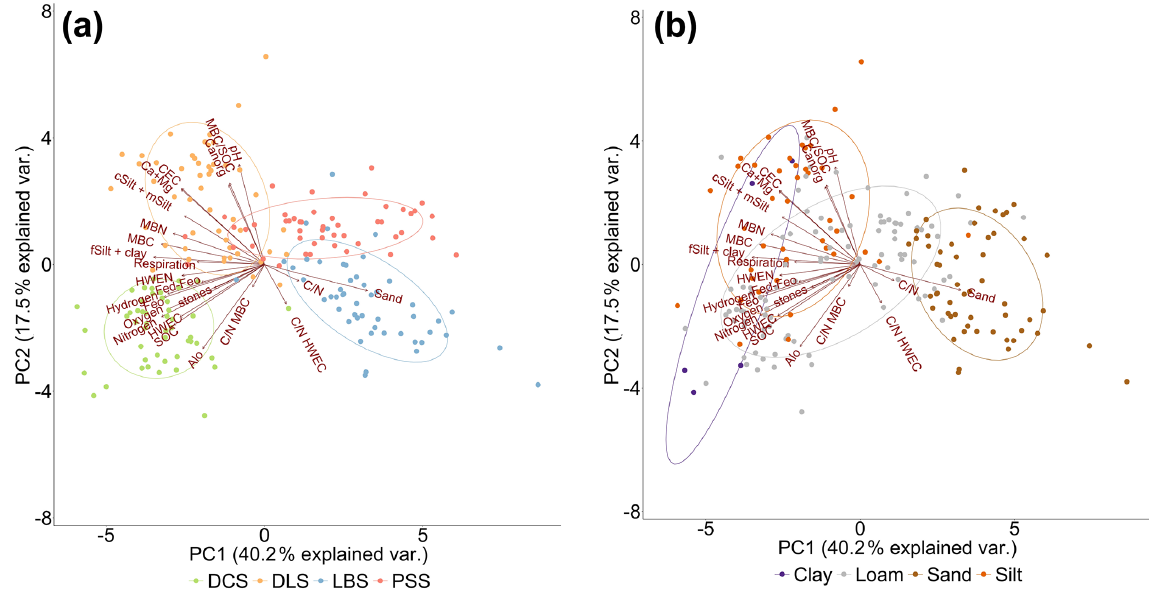
Figure 2. Principal components 1 and 2 with loadings of the variables indicating the clustering of the dataset according to parent material (a) and soil texture (b) . Parent materials are Devonian clay schist (DCS), sandy dolomitic limestone (DLS), Luxembourg sandstone (LBS), and Permian siltstone and fine sandstone